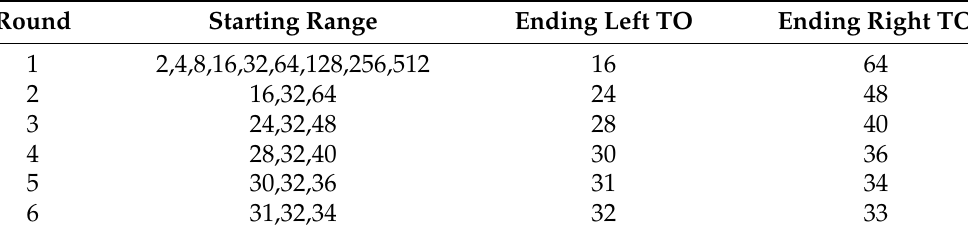
Table 3. Results of the bisection method used to complete the last part of the TO design